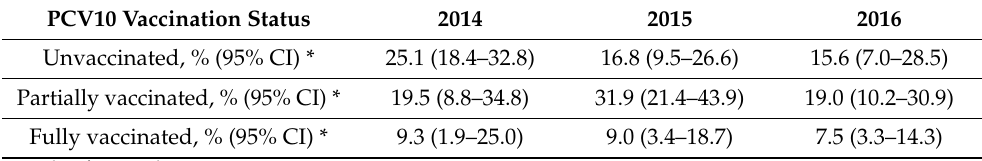
Table 4. VT Carriage rates by vaccination status across the three